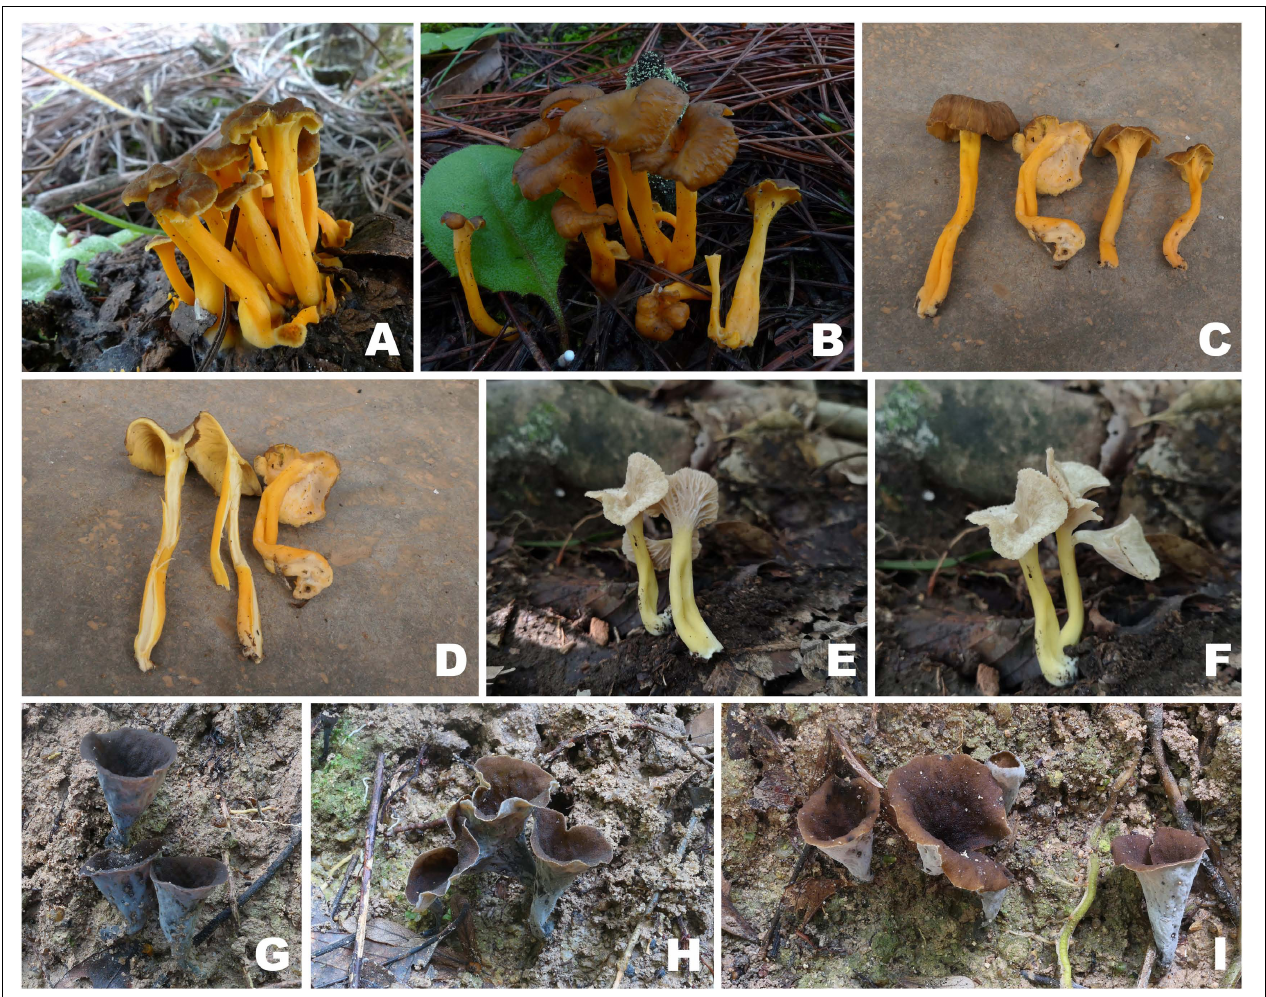
FIGURE 6 | Basidiomata of Craterellus species. (A–D) C. lutescens (A) FHMU6547; (B) FHMU6548; (C,D) FHMU6544; (E,F) C. minor (FHMU6554, holotype); (G–I) C. parvopullus (G) FHMU6557; (H) FHMU6555, holotype; (I) FHMU6556. Photos: (A,B) L.-P. Tang; (C,D) W.-H. Zhang; (E,F) P. Zhang; (G–I) N.-K. Zeng.